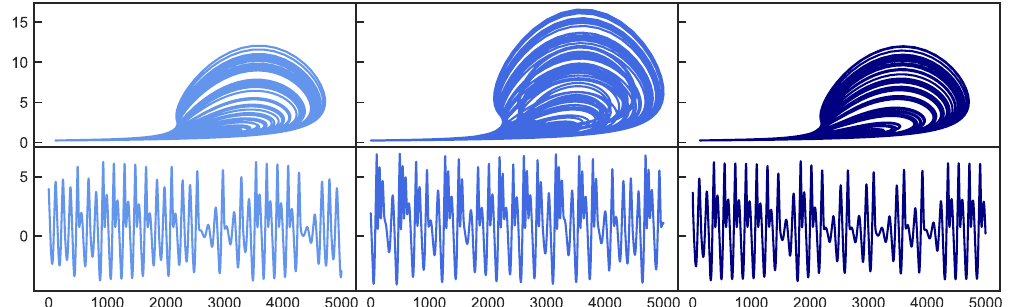
Figure 5. Chaotic to chaotic control for the Roessler system. Top: 2D attractor representation in the x–z plane. Bottom: X coordinate time series. Left plots show the original chaotic state which changes to a different chaotic state (middle) after tuning the order parameter. After applying the control mechanism, the system is forced into the initial chaotic state again